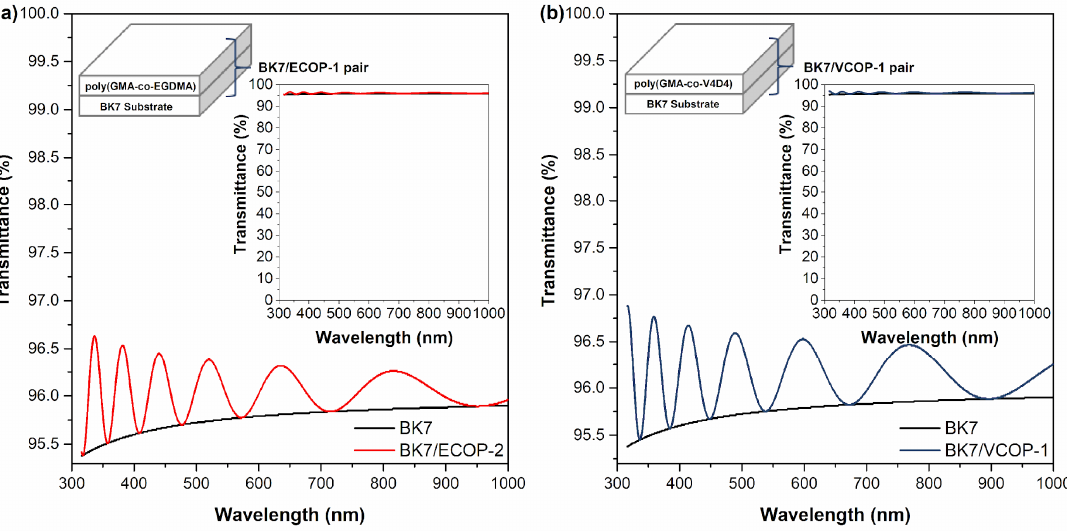
Figure 16. Modeled optical transmittance of ( a ) BK7/ECOP-2 and ( b ) BK7/VCOP-1 copolymer coat-